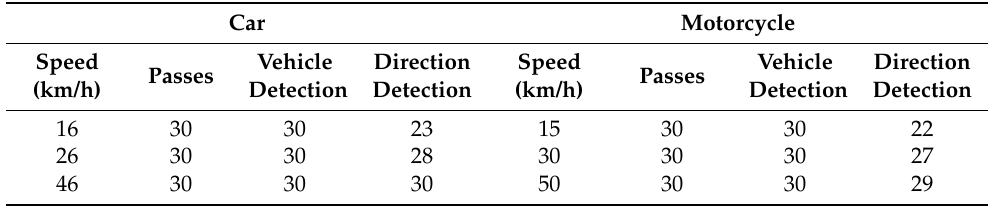
Table 3. Vehicle and direction detection results.